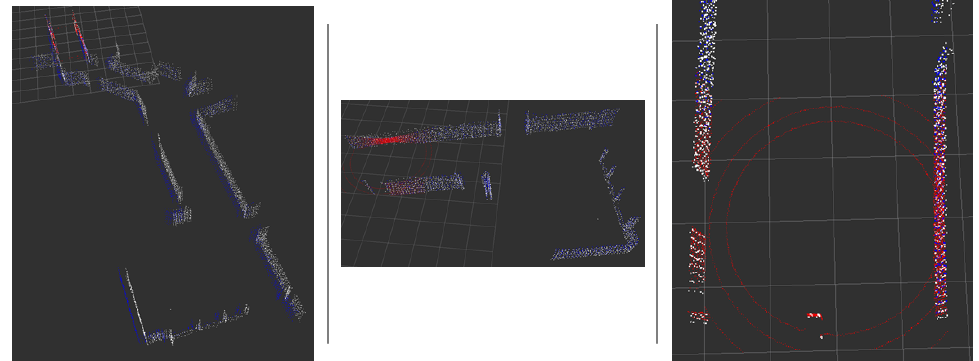
Figure 13. Comparison of resulting maps in simulation, obtained by hdl_graph_slam (blue points) and eSoC-SLAM (white points).